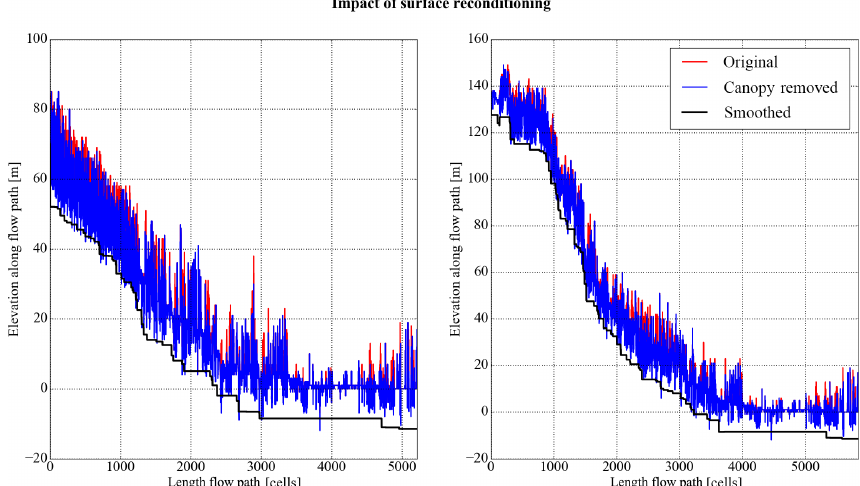
Figure 3. Impact of vegetation removal (canopy removed) and surface reconditioning (smoothed) on surface elevation along two exemplary flow paths compared to original HydroSHEDS-DEM data (original).